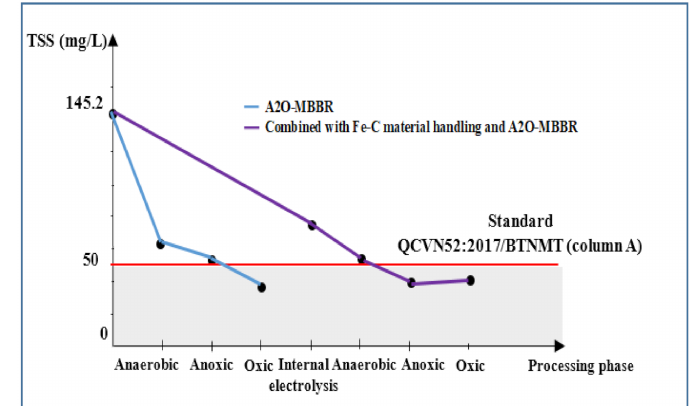
Figure 8. Treatment e ffi ciency of TSS (mg / L) via A2O-MBBR system and through treatment of Fe-C materials combined with A2O-MBBR